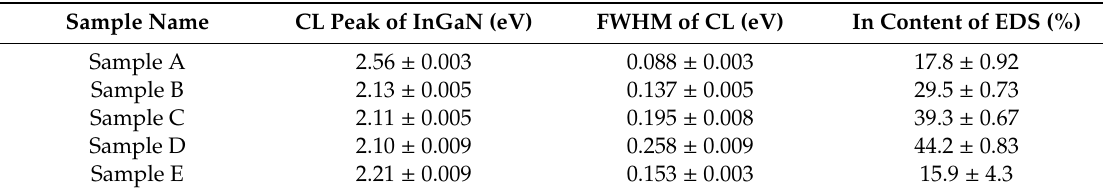
Figure 3. The CL spectra measure at room temperature for samples A to E. ( a1 )–( e1 ) show the SEI images of Samples A–E and ( a2 )–( e2 ) show the CL images of the samples for wavelengths of 480 nm,580 nm, 587 nm, 570 nm, and 560 nm, respectively. Table III. The summary of CL peak, FWHM, and In content for the samples of series I.